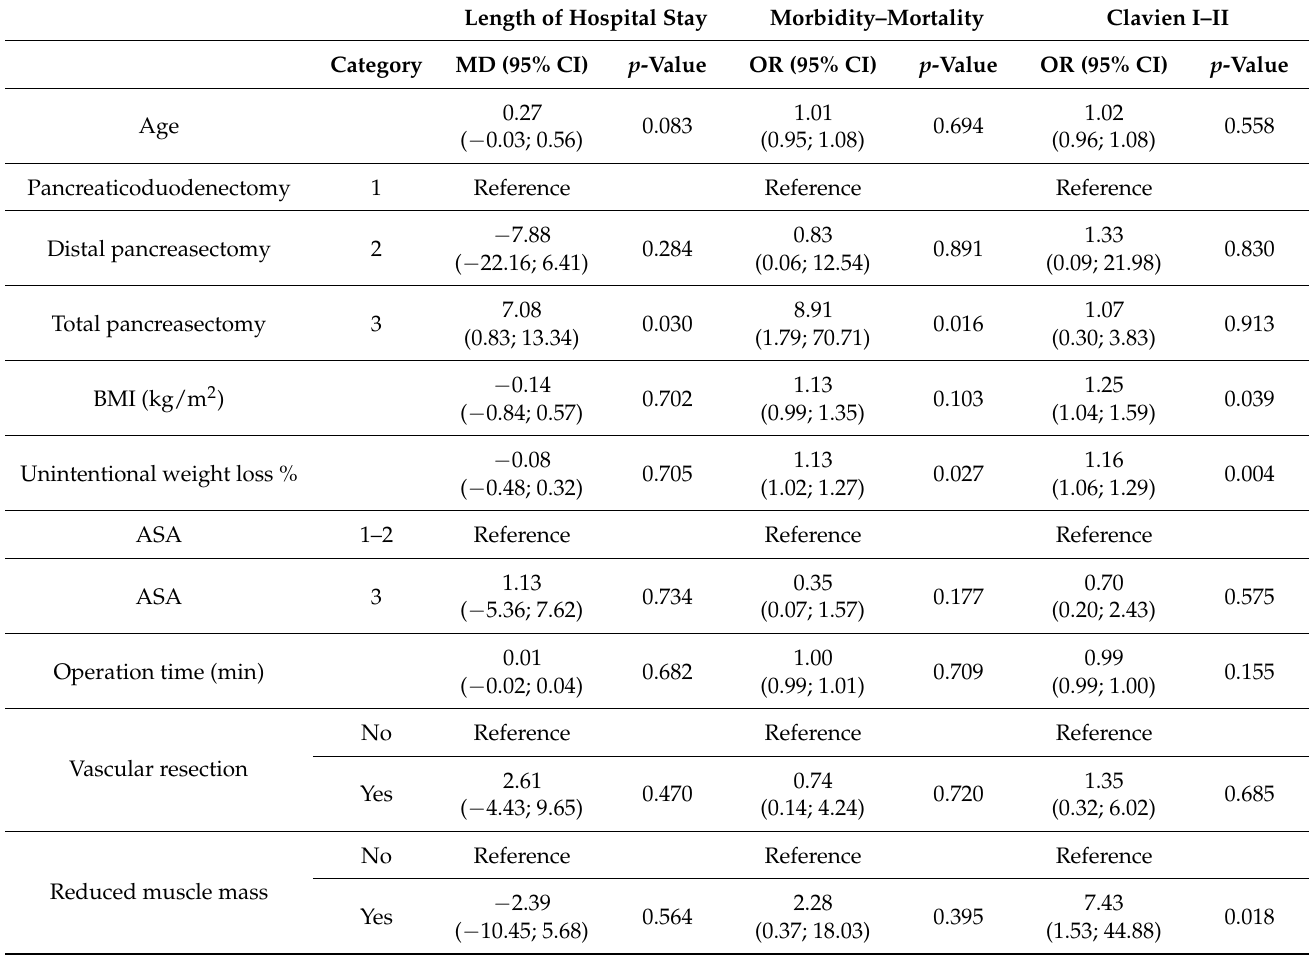
Table 3. Multivariable analysis for the risk of adverse clinical